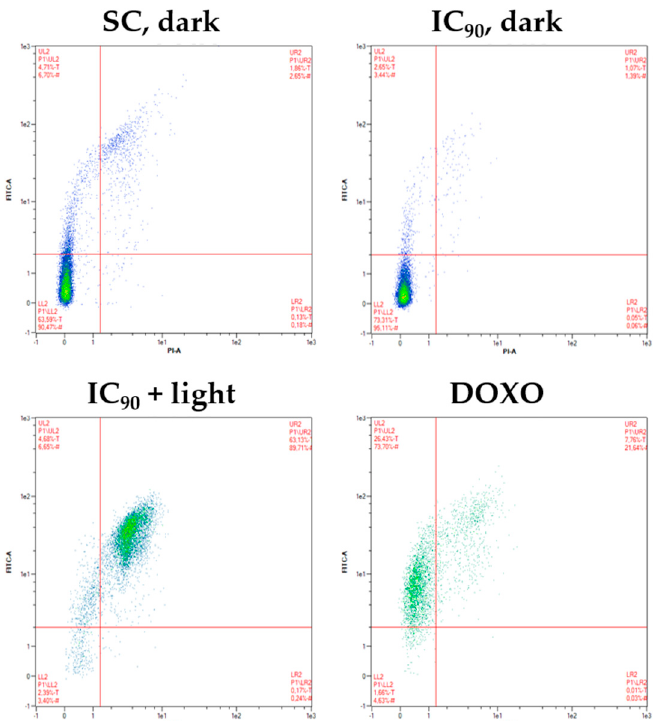
Figure A3. Representative dot plots after flow cytometric analysis of apoptosis induction in SISO cells. Cells were treated with solvent, DOXO, or the IC 90 of mTHPC. Afterwards, cells were kept in the dark